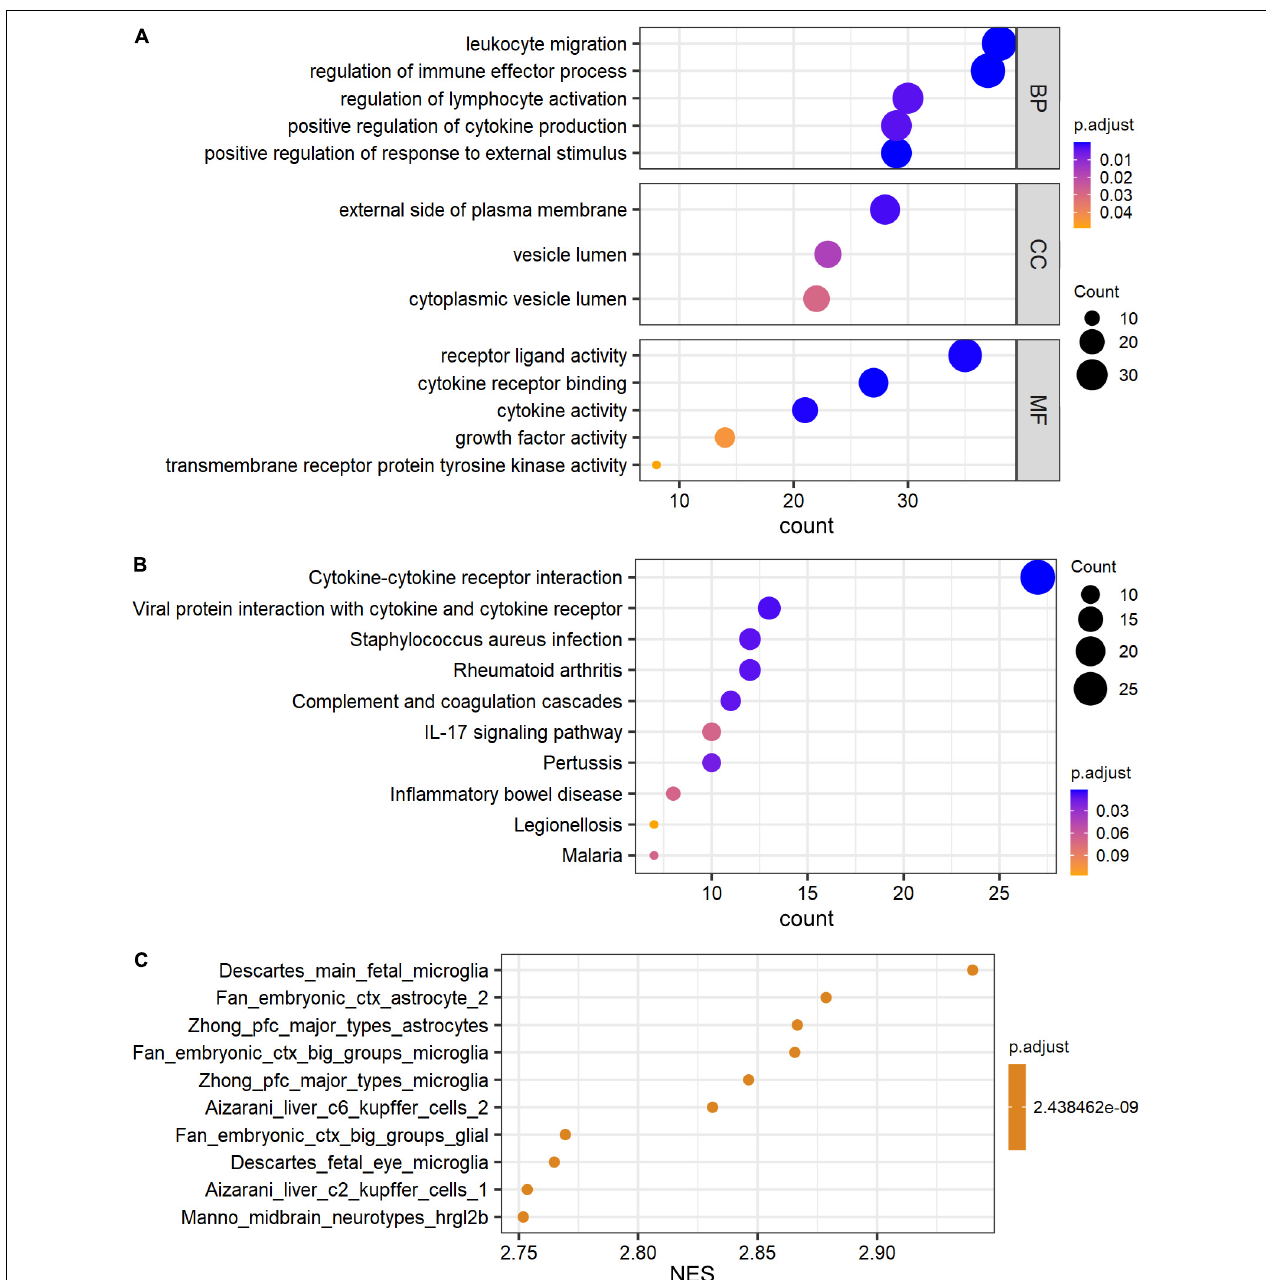
FIGURE 3 | GO and pathway analysis of differential expressed signatures. Top 5 of GO_MF, GO_BP, GO_CC (A) and pathway (B) enriched in the differential expressed mRNAs between TLE+HS and NTP. (C) Gene set enrichment analysis (GSEA) terms for cell type signature gene sets were ordered according to their NES. GO, Gene ontology; KEGG, Kyoto Encyclopedia of Genes and Genomes; MF, molecular function; BP, biological process; CC, cellular component; TLE+HS, epilepsy with hippocampal sclerosis; NTP, normal temporal or parietal